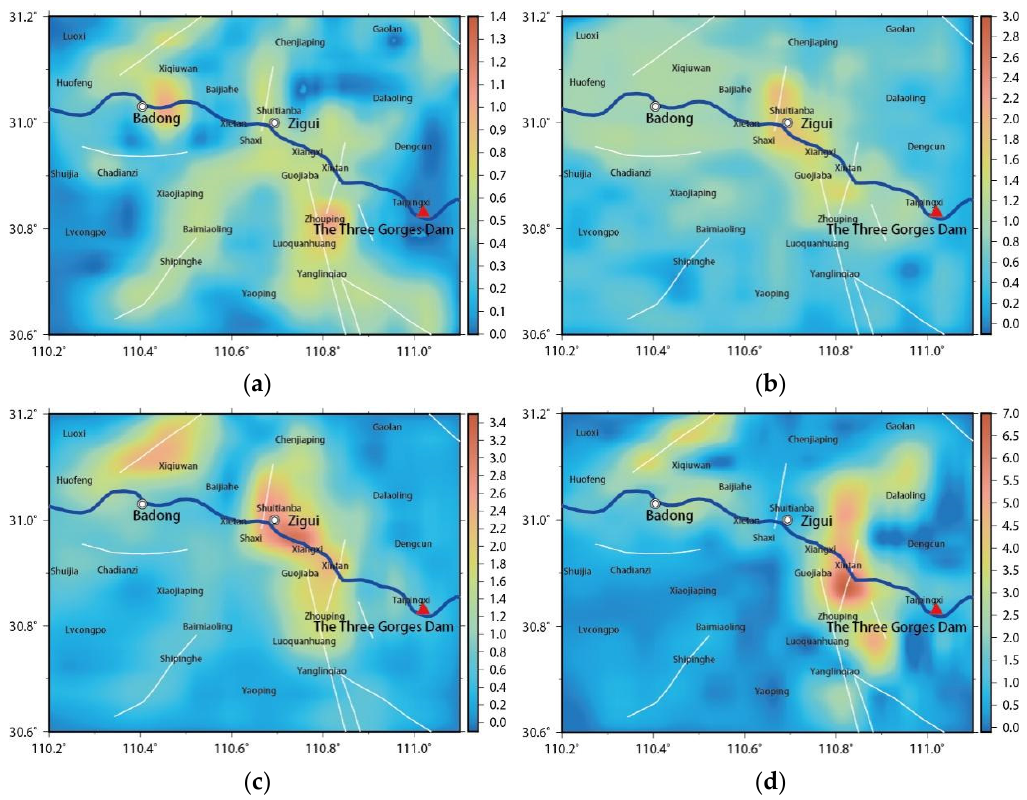
Figure 9. The maximum shear–strain field at 500 m below the ground in the study area: ( a ) before the impoundment, ( b ) 135 m stage, ( c ) 156 m stage, and ( d ) 175 m stage.